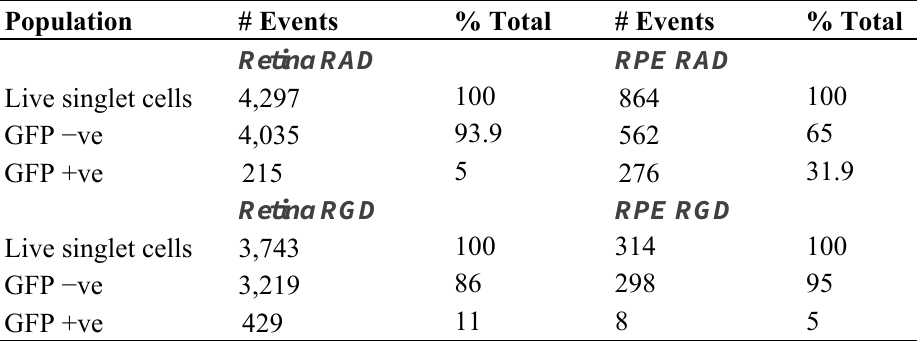
Table 2. Cell numbers from FACS analysis of AAV subretinal transduction with increased levels of MFG-E8. The number of cells that are transduced (GFP +ve) or not (GFP –ve) by virus expressing eGFP are